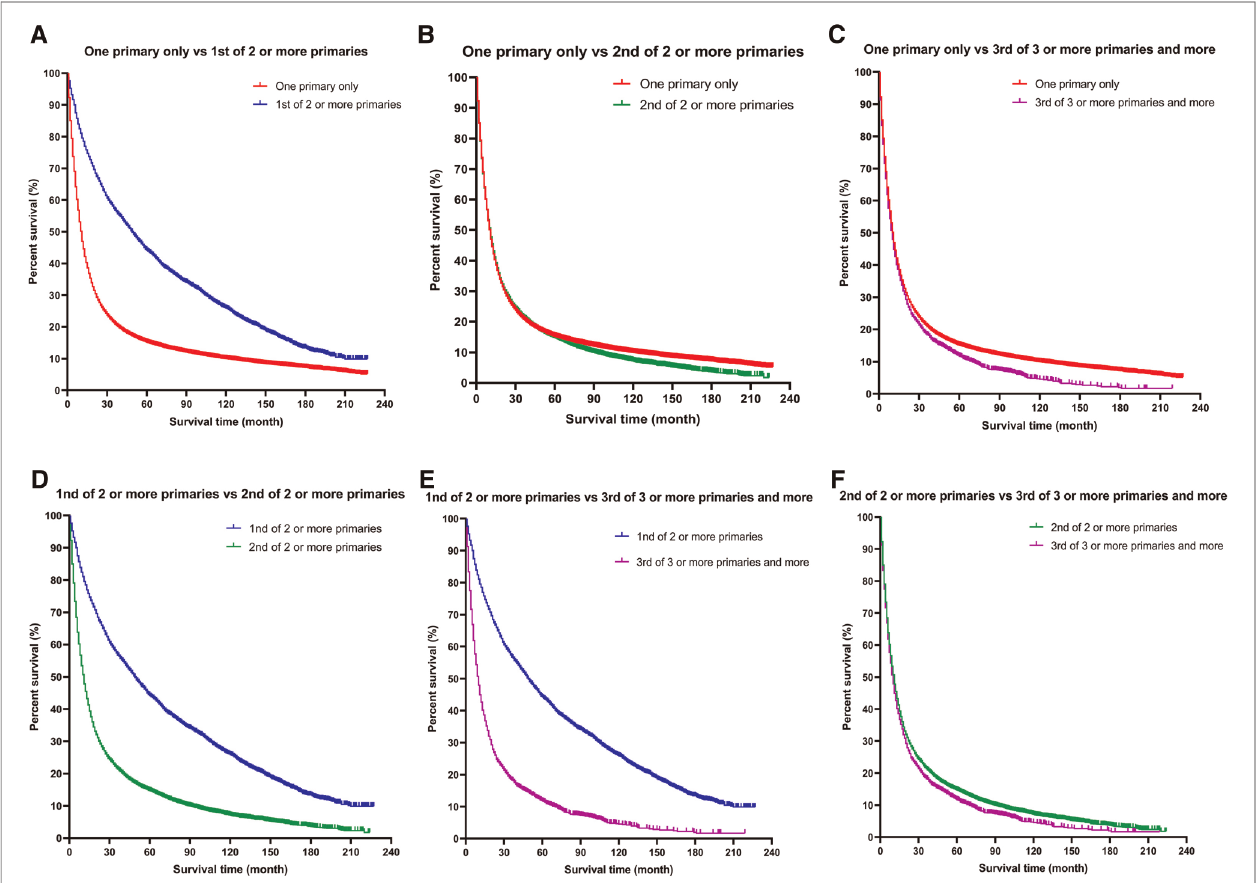
FIGURE 3 | A more detailed classi fi cation based on the order of diagnosis of esophageal cancer among multiple primary cancers. ( A ) One primary only vs. 1st of two or more primaries. ( B ) One primary only vs. 2nd of two or more primaries. ( C ) One primary only vs. 3rd of three or more primaries. ( D ) 1st of two or more primaries vs. 2nd of two or more primaries. ( E ) 1st of two or more primaries vs. 3rd of three or more primaries. ( F ) 2nd of two or more primaries vs. 3rd of three or more